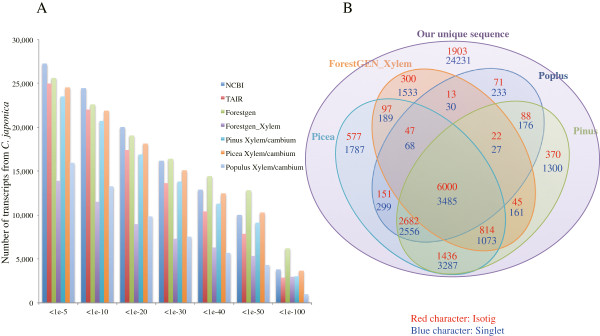
Sequence similarities. A) Number of transcript sequences from C. japonica cambium region similar to sequences in the NCBI, TAIR, ForestGen, ForestGen_Xylem, pine, spruce, and poplar databases according to BLASTx and tBLASTx E-value cutoff values. B) Venn diagram showing the overlap between our collected unique sequences and sequences in four other databases according to a tBLASTx search (E-value <1e-5).